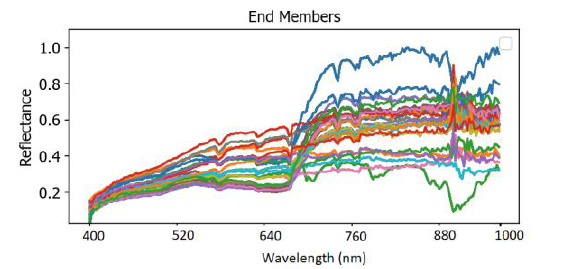
Figure 7. Consolidated End members extracted from the Ramgarh crater and the vicinity (based on Figure 4)